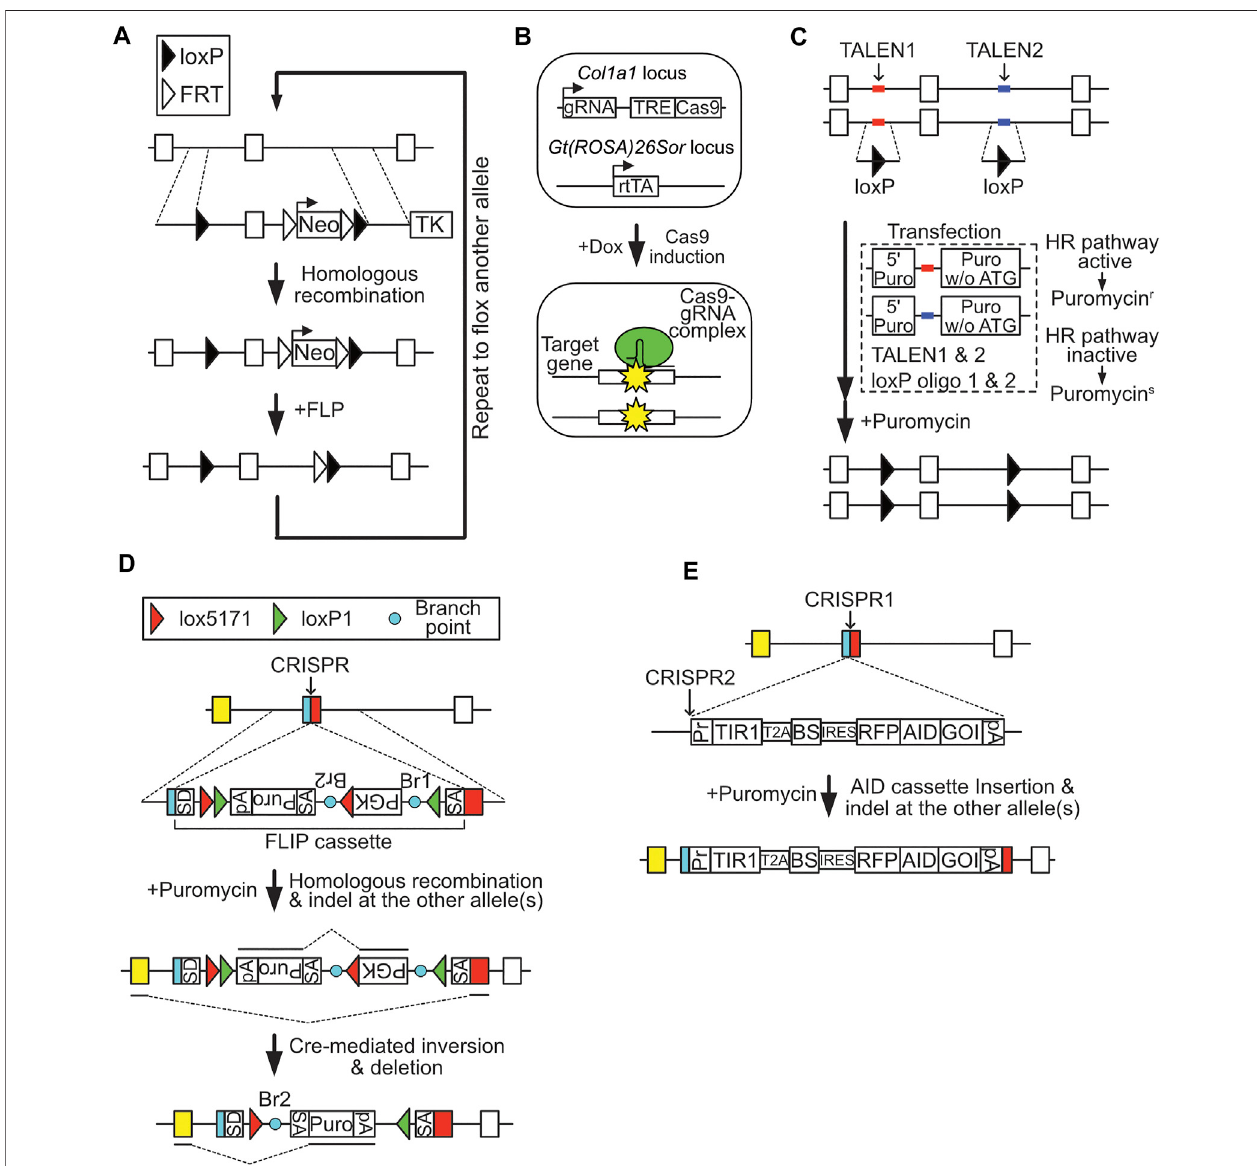
FIGURE1| Methods forproducing conditional knockout(cKO) cells. (A) Conventional cKOmethod. Filledtriangle,loxP site; empty triangle, FRTsite. (B) Inducible Cas9-mediated cKO method. (C) Reporter construct-assisted cKO method. (D) cKO using a FLIP cassette. SD, splicing donor sequence; SA, splicing acceptor sequence; Br, branch point; green triangle, loxP1 site; red triangle, lox5171 site; pA, polyadenylation signal. (E) cKO using the AID system.